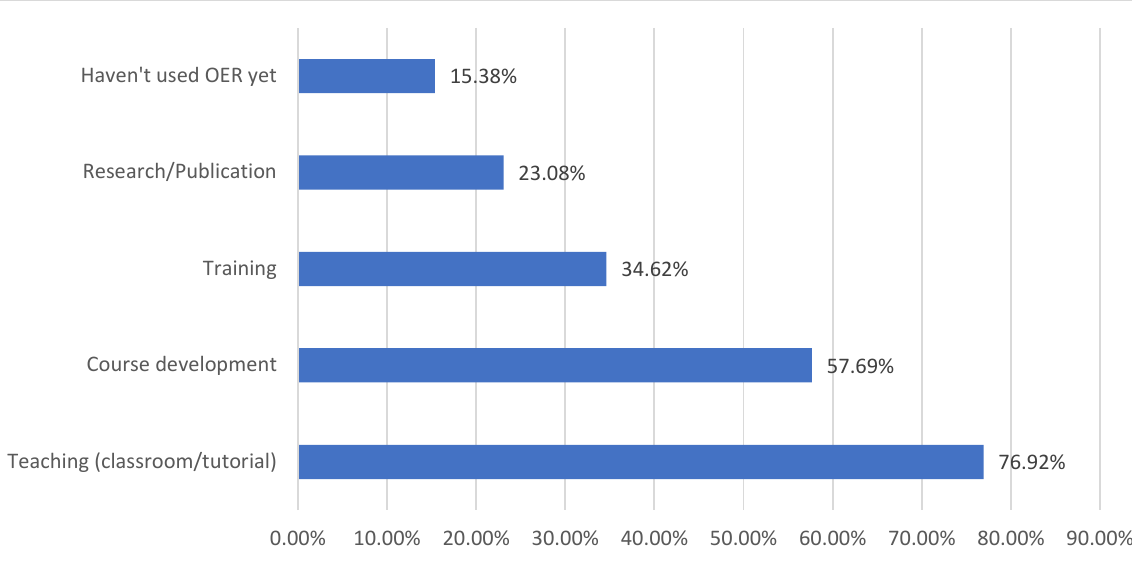
Figure 4. Results of follow-up survey on OER